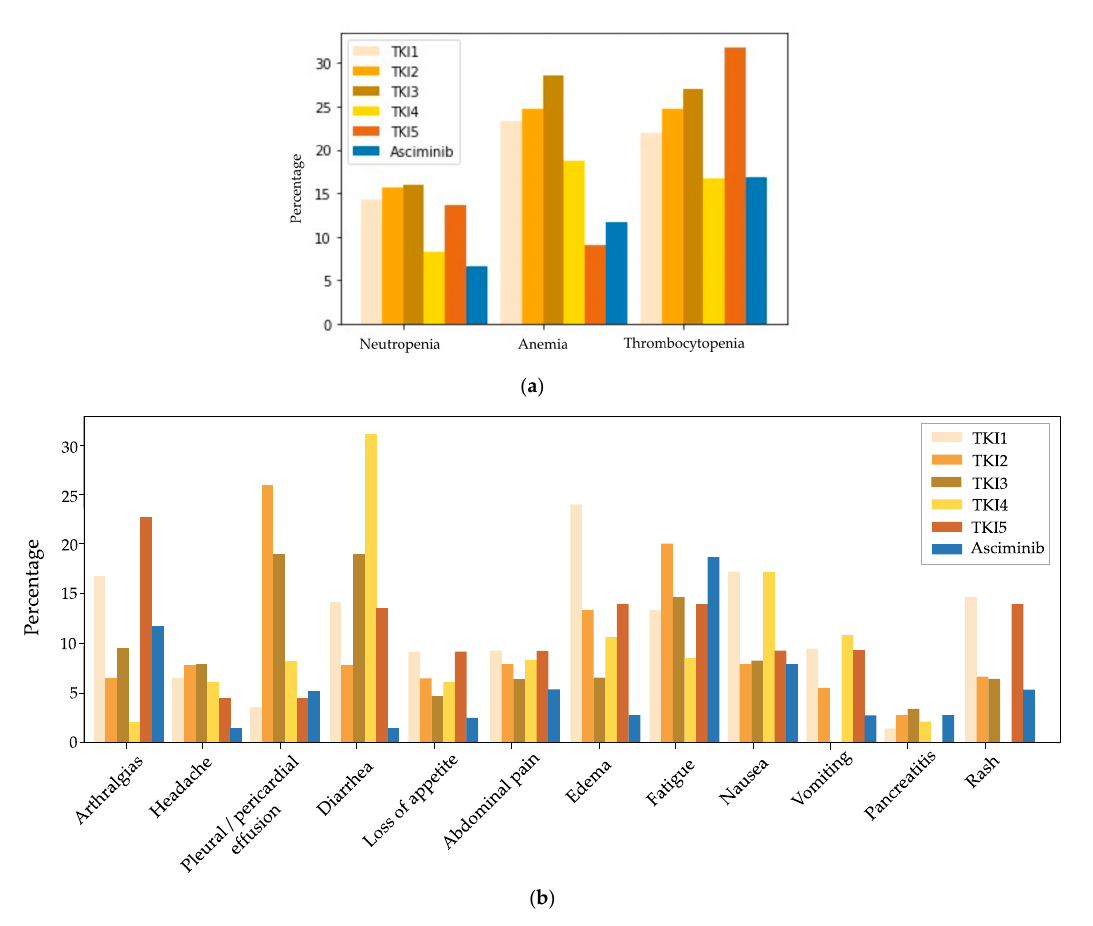
Figure 4. ( a ) Frequency of hematologic toxicity with previous TKI versus asciminib. ( b ) Frequency of extra-hematologic toxicity with previous TKI versus asciminib. In pale orange to brown: the re- ported frequency of cytopenias for the different lines prior to asciminib. TKI1 refers to the first line of treatment and TKI2–5 to the successive lines. All previous lines correspond to one of the classical TKIs: either imatinib, dasatinib, nilotinib, bosutinib, or ponatinib. In blue color: the frequency re- ported with asciminib.